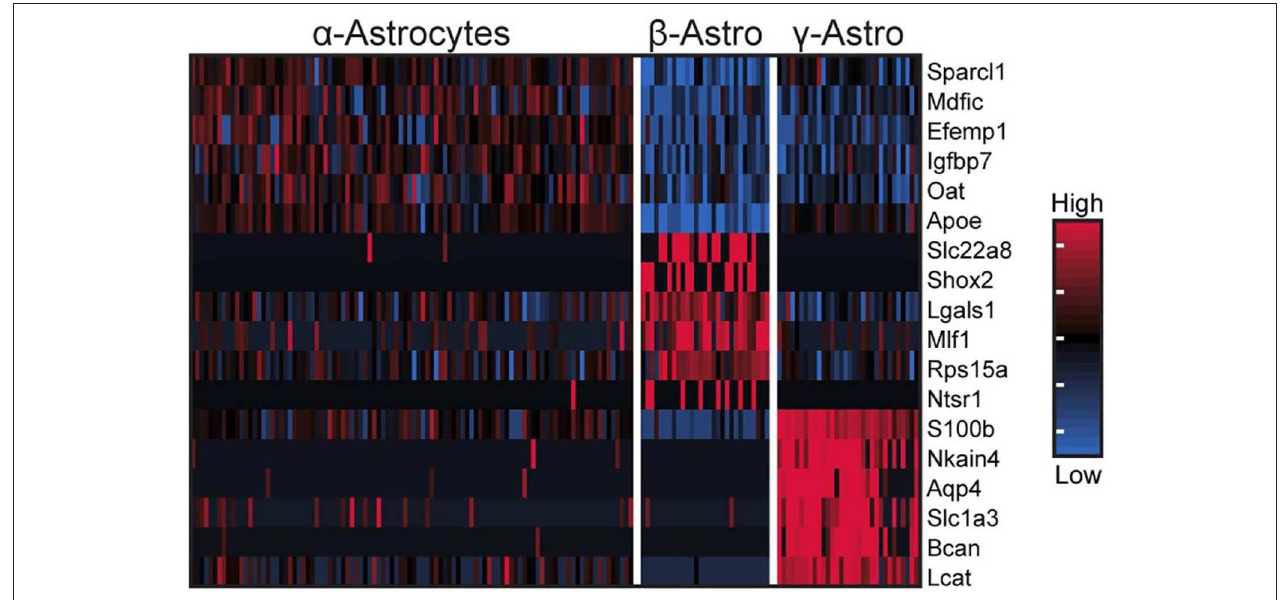
FIGURE 5 | scRNA-seq reveals three transcriptionally distinct astrocyte populations. Heatmap of expression values for the top 6 highest differentially expressed genes (by effect size) for α -, β -, and γ -astrocytes. Values are Z-scores of counts calculated between all cells of the three cell types. Each column represents one cell; a random sample of 100 cells from α -astrocytes are shown; all β - and γ -astrocytes are shown. See also Figure S1 in Mays et al. (43) for more information. Reproduced from Mays et al. ( 43). This figure and associated legend is published with permission of the original publisher under license